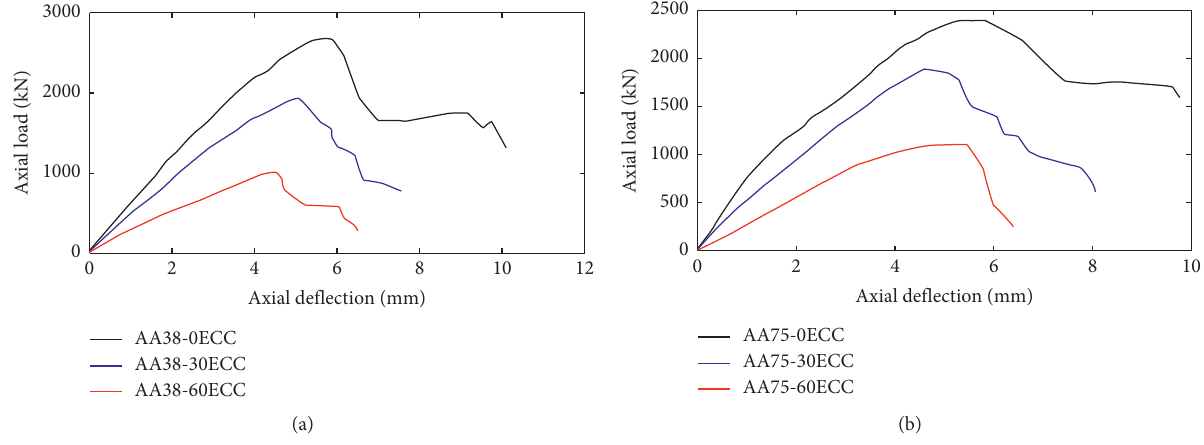
Figure 9: Influence of eccentricity on the AS of the GFHF